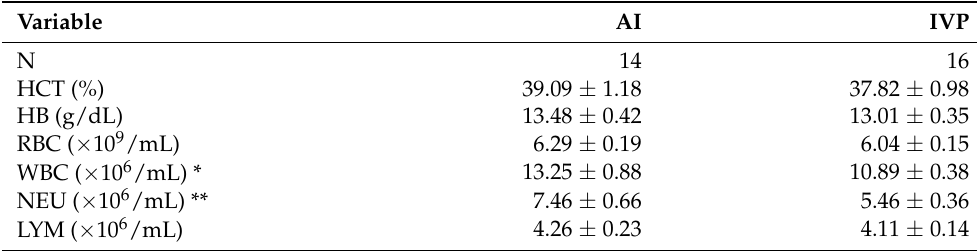
Table 5. Hematological data from pigs derived from artificial insemination (AI) and in vitro embryo production (IVP) at 3.5 years of age. The parameters analyzed were hematocrit (HCT), hemoglobin (HB), concentration of red blood cells (RBC), concentration of white blood cells (WBC), neutrophils (NEU), and lymphocytes (LYM). Data are expressed as mean ± s.e.m. Variable N HCT (%) HB (g/dL) RBC ( × 10 9 /mL) WBC ( × 10 6 /mL) * LYM ( × 10 6